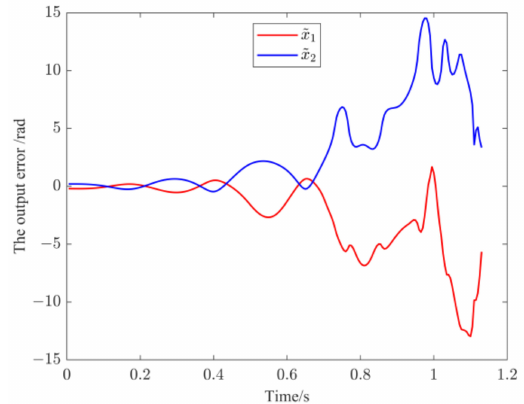
when τ f is off. θ